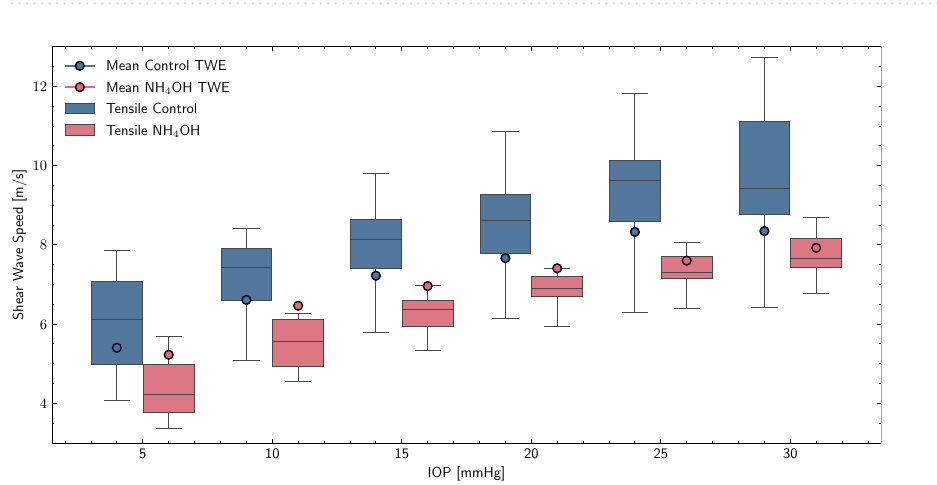
Figure 6. Comparison of shear wave speed from uniaxial tensile tests and TWE (torsional wave elastography) results for each intraocular pressure (IOP). The boxplot of the tensile tests shows the same trend as the mean shear wave speed of TWE (blue points—control samples, red points— NH 4 OH